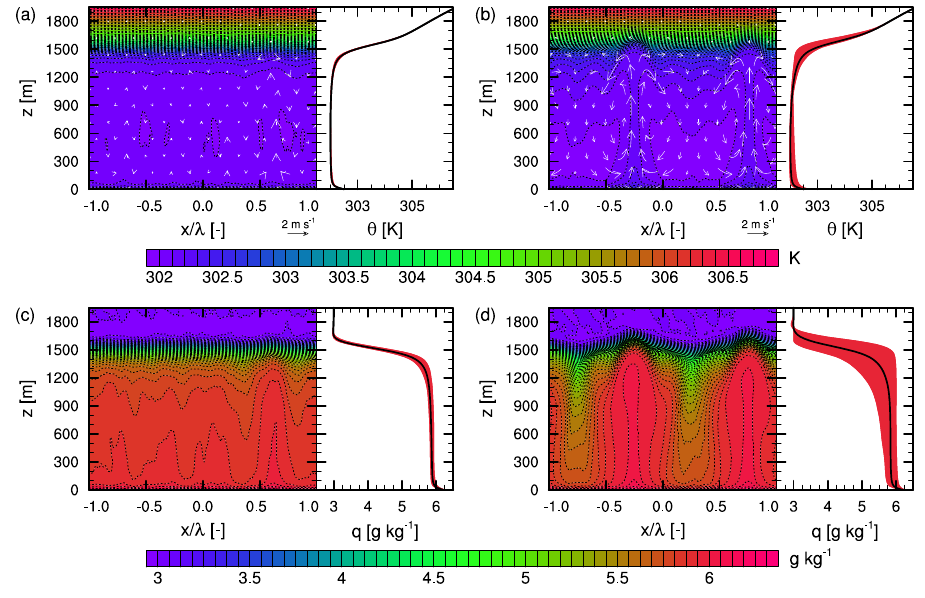
Fig. 3. Potential temperature and moisture for the homogeneous case (a, c) and the heterogeneous case (b, d) . Each figure consists of two panels. The first panel shows these variables averaged over the fourth hour of simulated time and the y -direction, while the second panel shows an additional average in the x -direction. The red area in the second panel shows the variability in the x -direction of the temporal and y averaged values. The potential temperature, θ , is shown on top (a, b) and the specific humidity, q , at the bottom (c, d) . Wind direction and magnitude are indicated by vectors (a, b) . The x -coordinate is scaled by the length scale of heterogeneity, λ , which is twice the patch size.